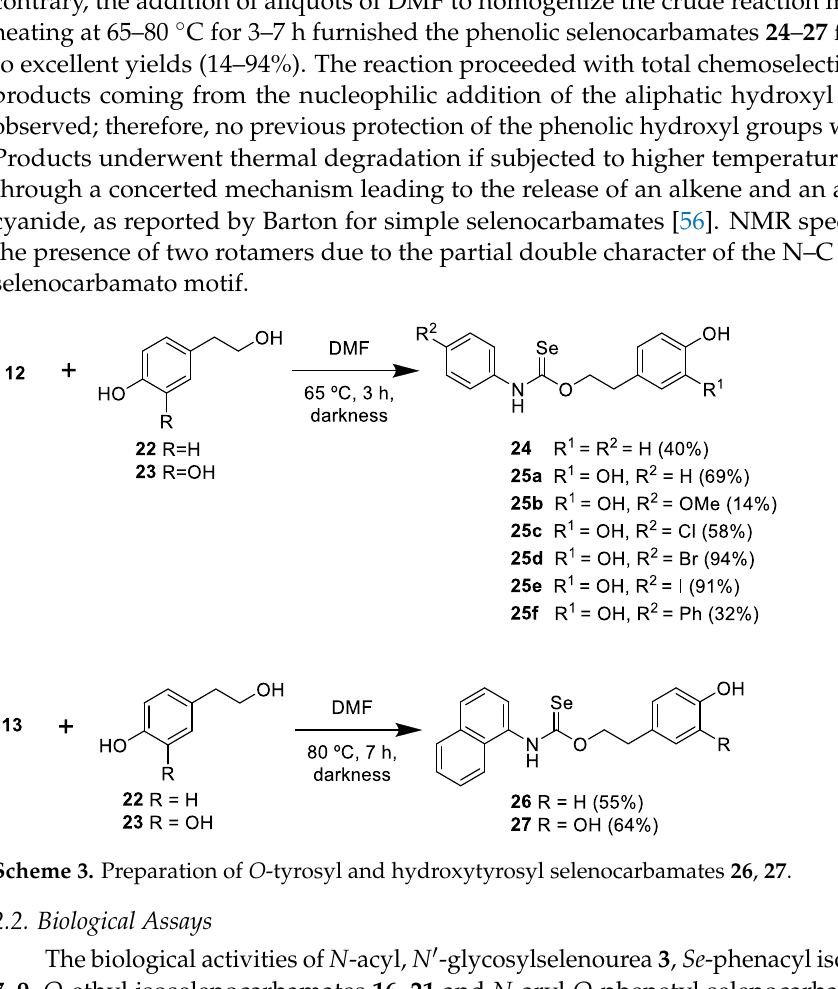
Table 1. Antioxidant assays for organoselenium derivatives.